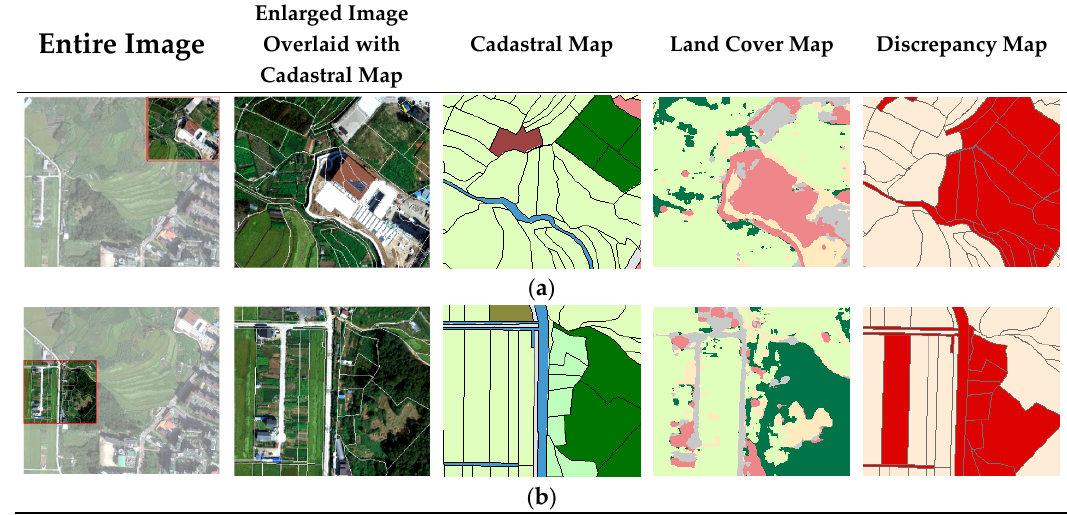
Figure 14 . Enlarged hyperspectral UAV images, cadastral maps, land cover maps, and discrepancy maps in two zones of Site 2: ( a ) subset-1 and ( b ) subset-2.